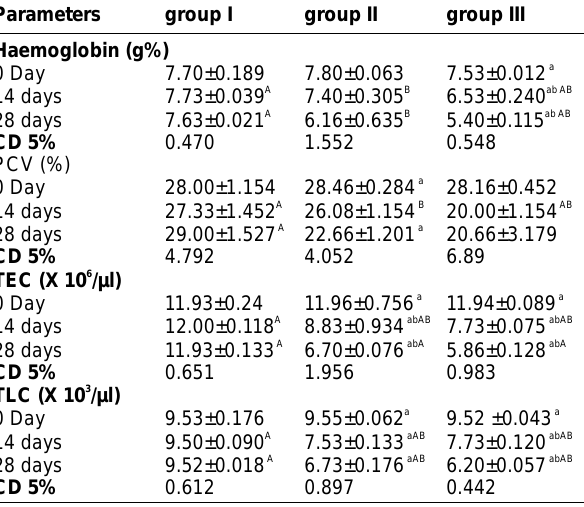
*Treatment with sodium thiosulphate (50 mg/kg body weight IV route) and glutathione (0.25 mg/kg body weight, IM route) *Mean values bearing common superscripts with small letters differ significantly (P< 0.05) when compared vertically with in the same column and mean values bearing common superscripts with capital alphabets differ significantly (P<0.05) when compared horizontally in the same row.